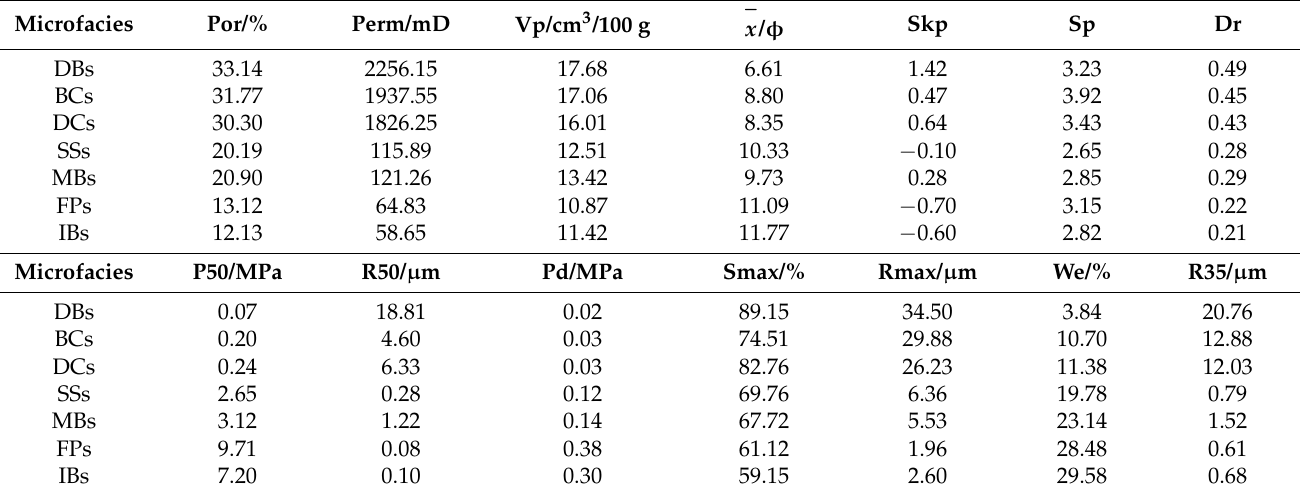
Table 2. Mineral composition of the Guantao Formation. Table 3. Pore throat characteristics of the Guantao